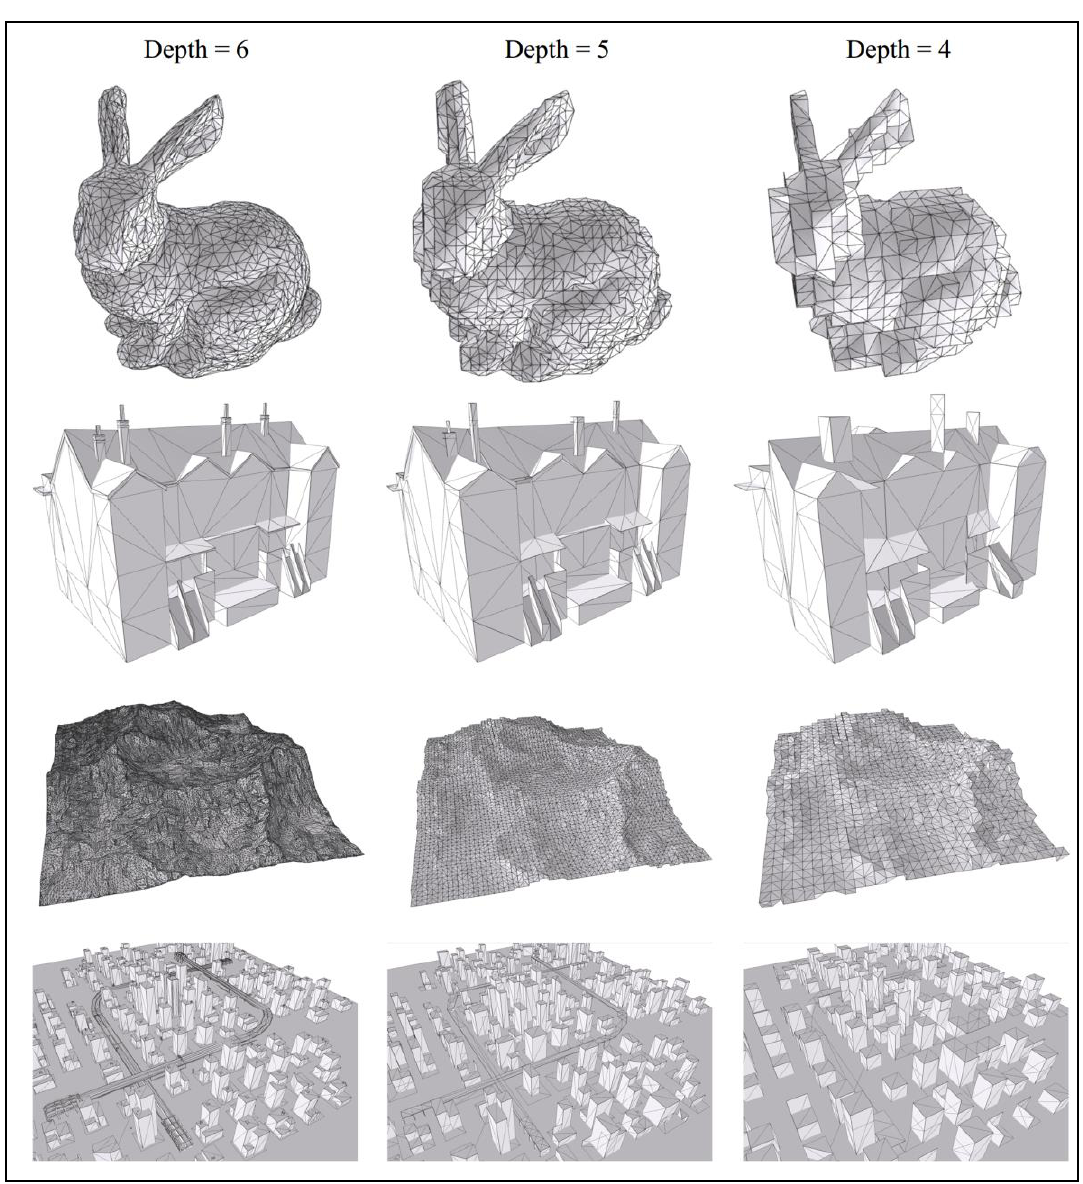
Figure 5. details revealed by models at different